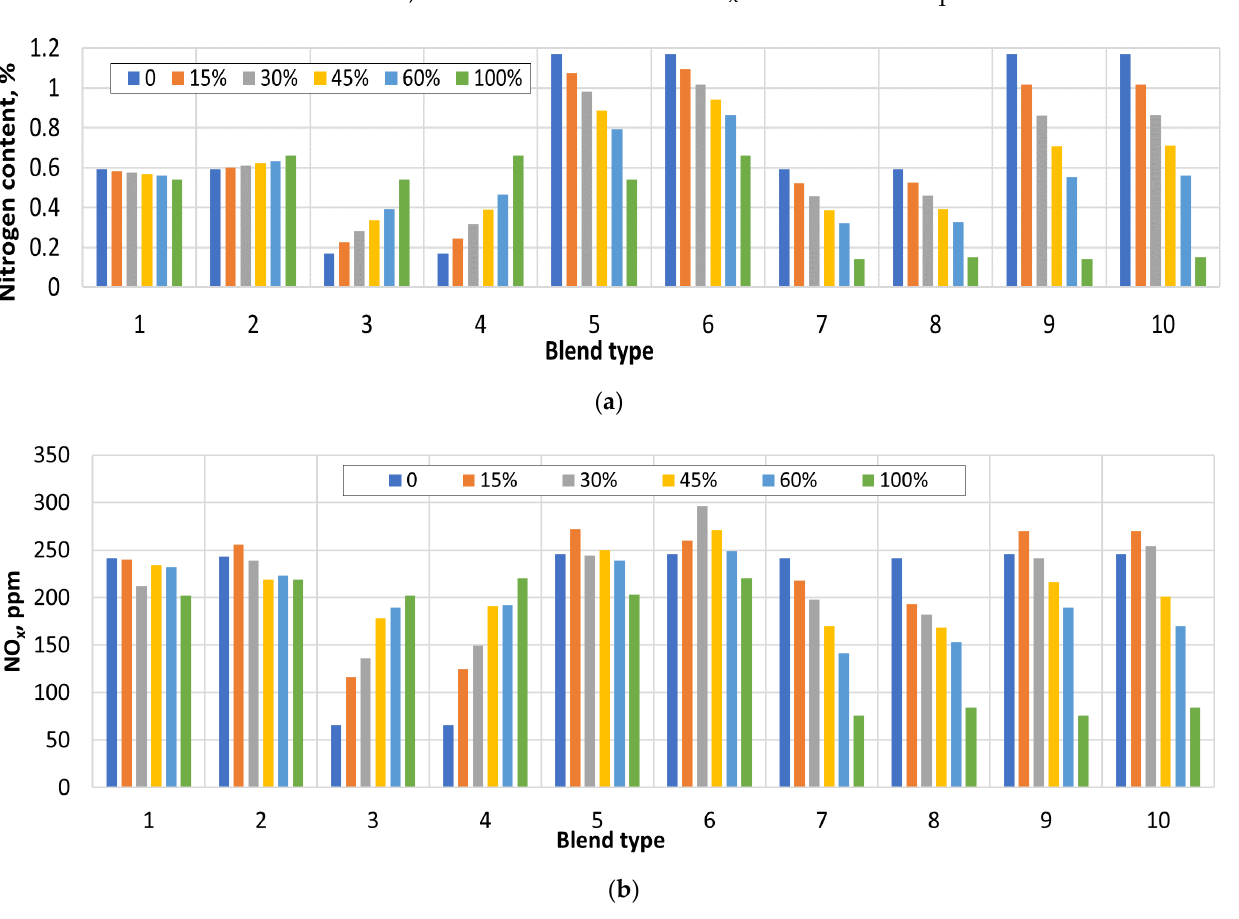
Figure 13. The mass fraction of nitrogen ( a ) in blends and polluting NO x emissions in the products ( b ) of blends (for composition of blends see Figure 4). ( b ) of blends (for composition of blends see Figure